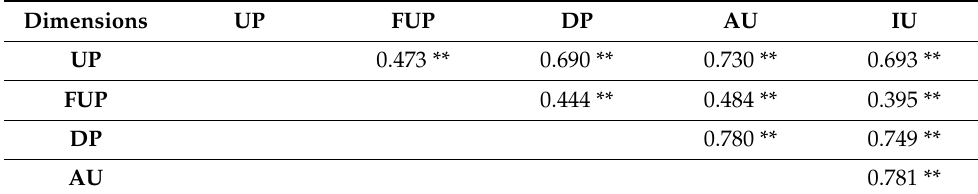
Table 5. TAM correlations.